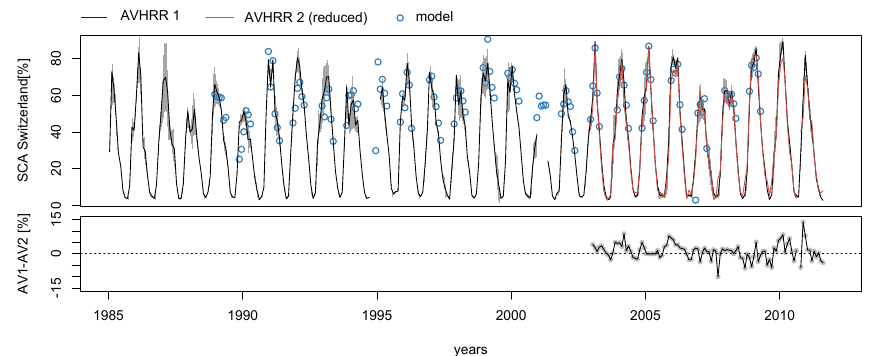
Fig. 10. Time series (1985–2011) of monthly values of SCA for Switzerland (AVHRR 1; black) including monthly standard deviation (gray shaded area) compared to the same measures derived from gridded station data (blue dots). AVHRR 2 (red) displays the snow cover data set with reduced number of scenes. Differences between the full data set (AVHRR 1) and the artificially reduced data set (AVHRR 2) are illustrated in the lower graph.